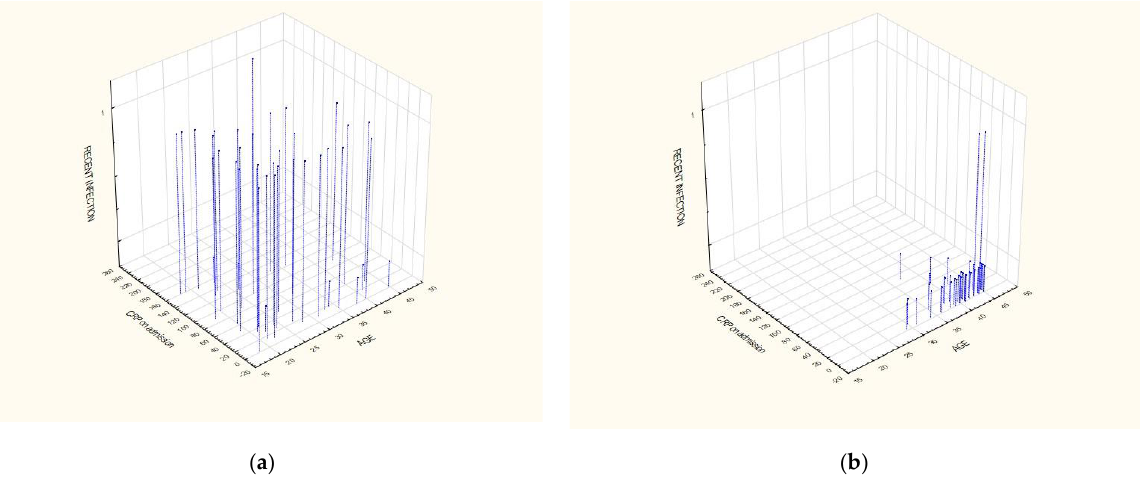
Figure 4. Three-dimensional charts showing the distribution of variables based on age, CRP level on admission, and history of recent infection: ( a ) Myocarditis; ( b ) Myocardial